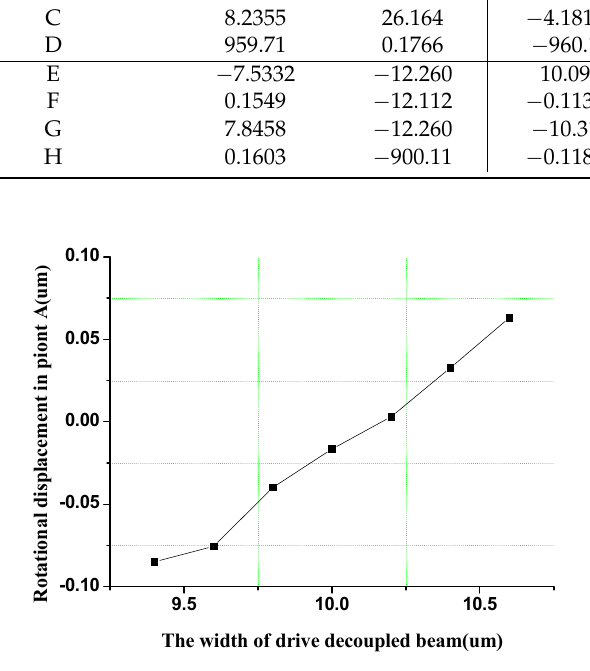
Figure 7. Rotational displacement simulation of sense frame in anti-phase drive mode.